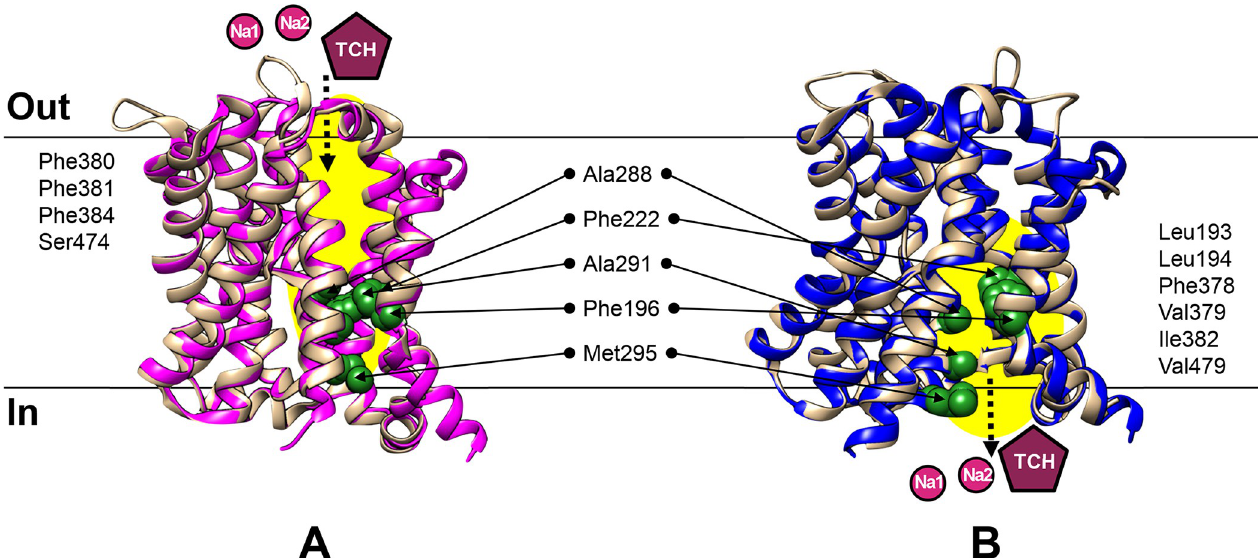
Fig 2. Conformation changes of CsSBAT accompanied with transport of Na + and taurocholate (TCH). Both OF-CsSBAT (A) and IF-CsSBAT (B) are colored in tan. OF-YfASBT (A) is colored in pink and IF-NmASBT (B) in blue. ASBTs presenting identical conformation are superposed. Tunnel leading to the TCH-binding site is visualized in yellow eclipse. Residues forming TCH-binding cavity are depicted as green spheres in CsSBAT. Other residues participating in TCH-binding site are provided at each side. Na + ions are in purple circle (Na1 and Na2). Taurocholate (TCH) is depicted as maroon pentagon.